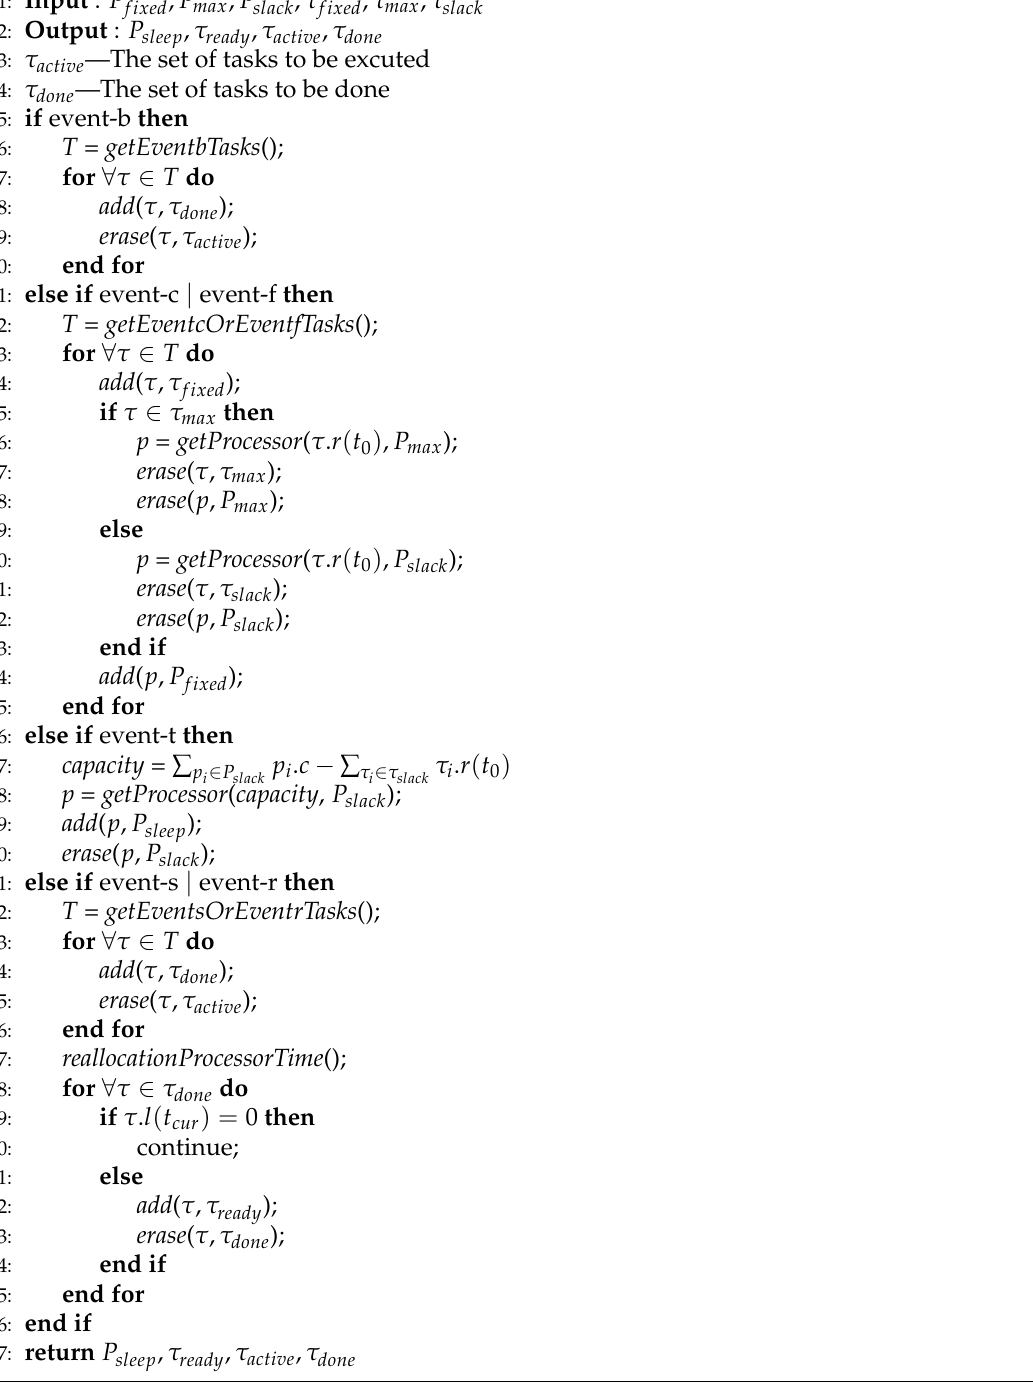
Algorithm 4 Movement of elements during rescheduling in the T-L